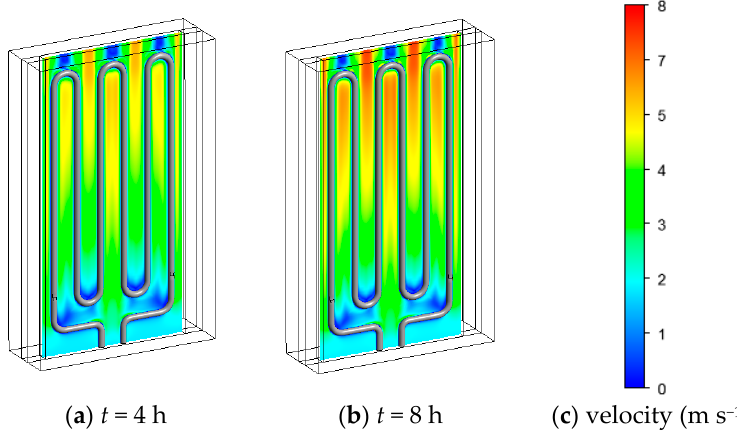
Figure 6. The velocity contour at the middle cross-section of the flow channel at different charging time.